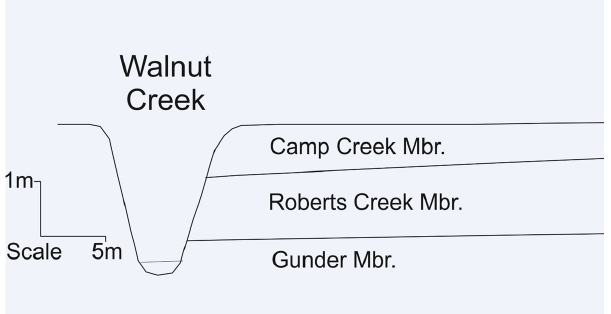
Figure 2. Floodplain cross section depicting stratigraphic position and scale of streambank alluvial units, Walnut Creek, Iowa. Image adapted from Schilling et al. [27].